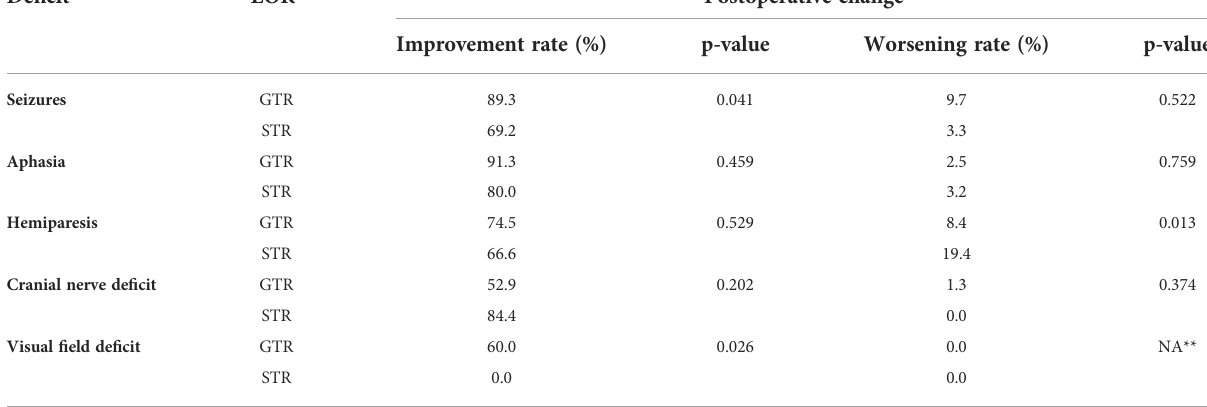
TABLE 3 Improvement and worsening rates of seizures and focal neurological de fi cits strati fi ed by gross total resection (GTR) vs. subtotal resection (STR) in NSBM patients. De fi cit